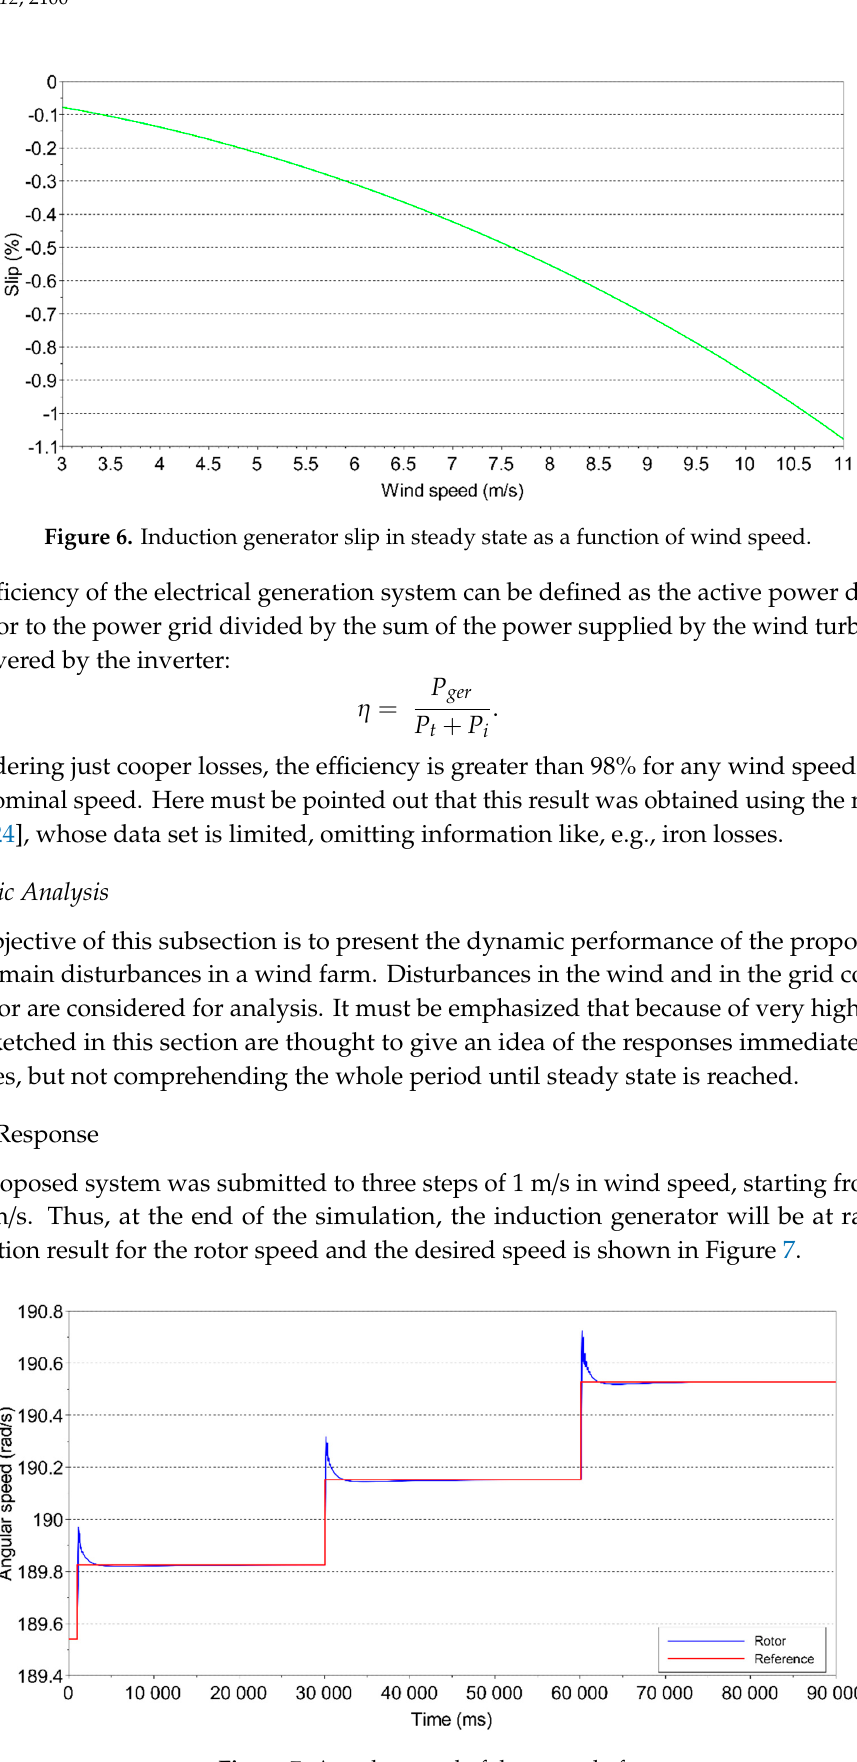
Figure 8. Frequency at the inverter output. The power generated by the induction generator and its turbine and inverter contributions are presented in Figure 9.